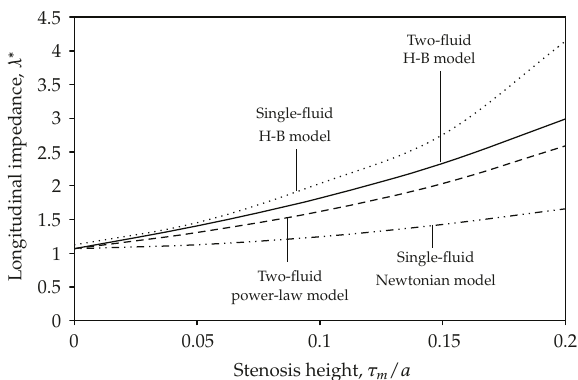
Figure 11: Variation of longitudinal impedance to flow with the critical height of the stenosis at z (cid:7) 15 and t (cid:7) 0.5 with α (cid:7) 0.95, μ H (cid:7) 0.035, and μ N (cid:7) 0.3 μ H .